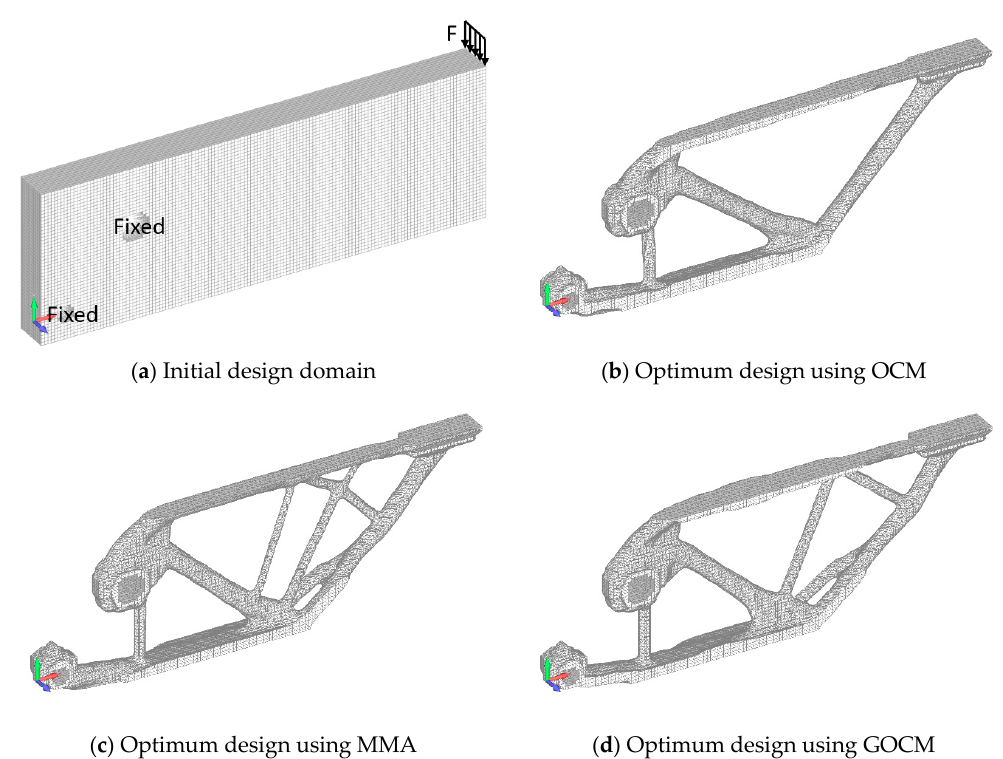
Figure 4. The initial design domain and optimum designs using different methods for the gripper-arm model.